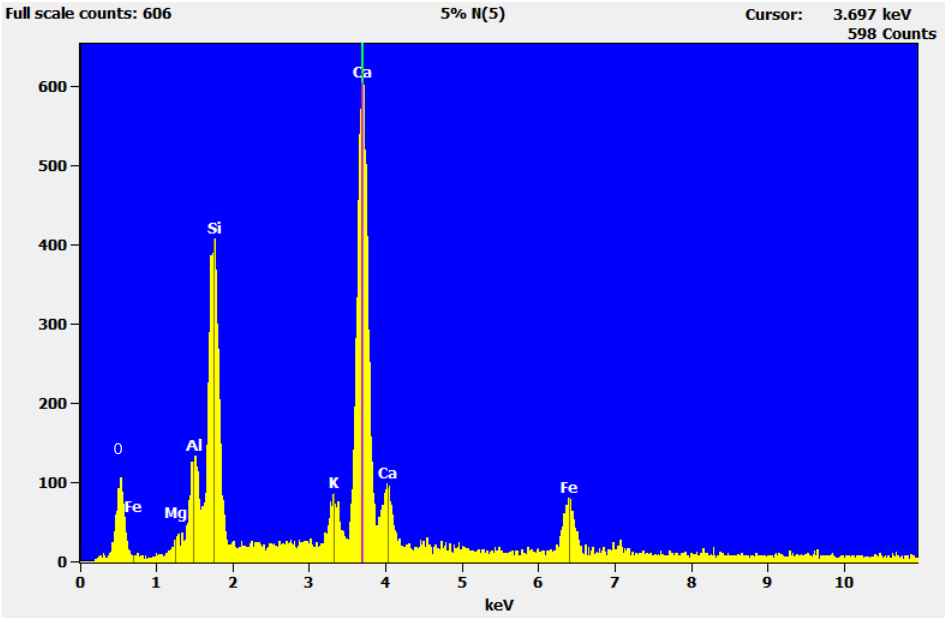
Figure 15. EDS spectrum of TQ5 at 28 d.